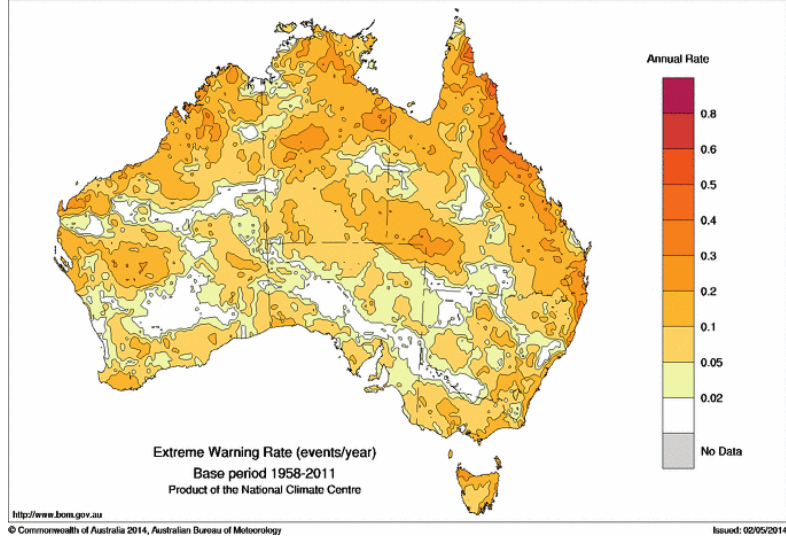
Figure 10 . Average annual occurrence of TDPs with EHF above the extreme threshold in the period 1958–2011. Values are expressed in the form of TDPs per